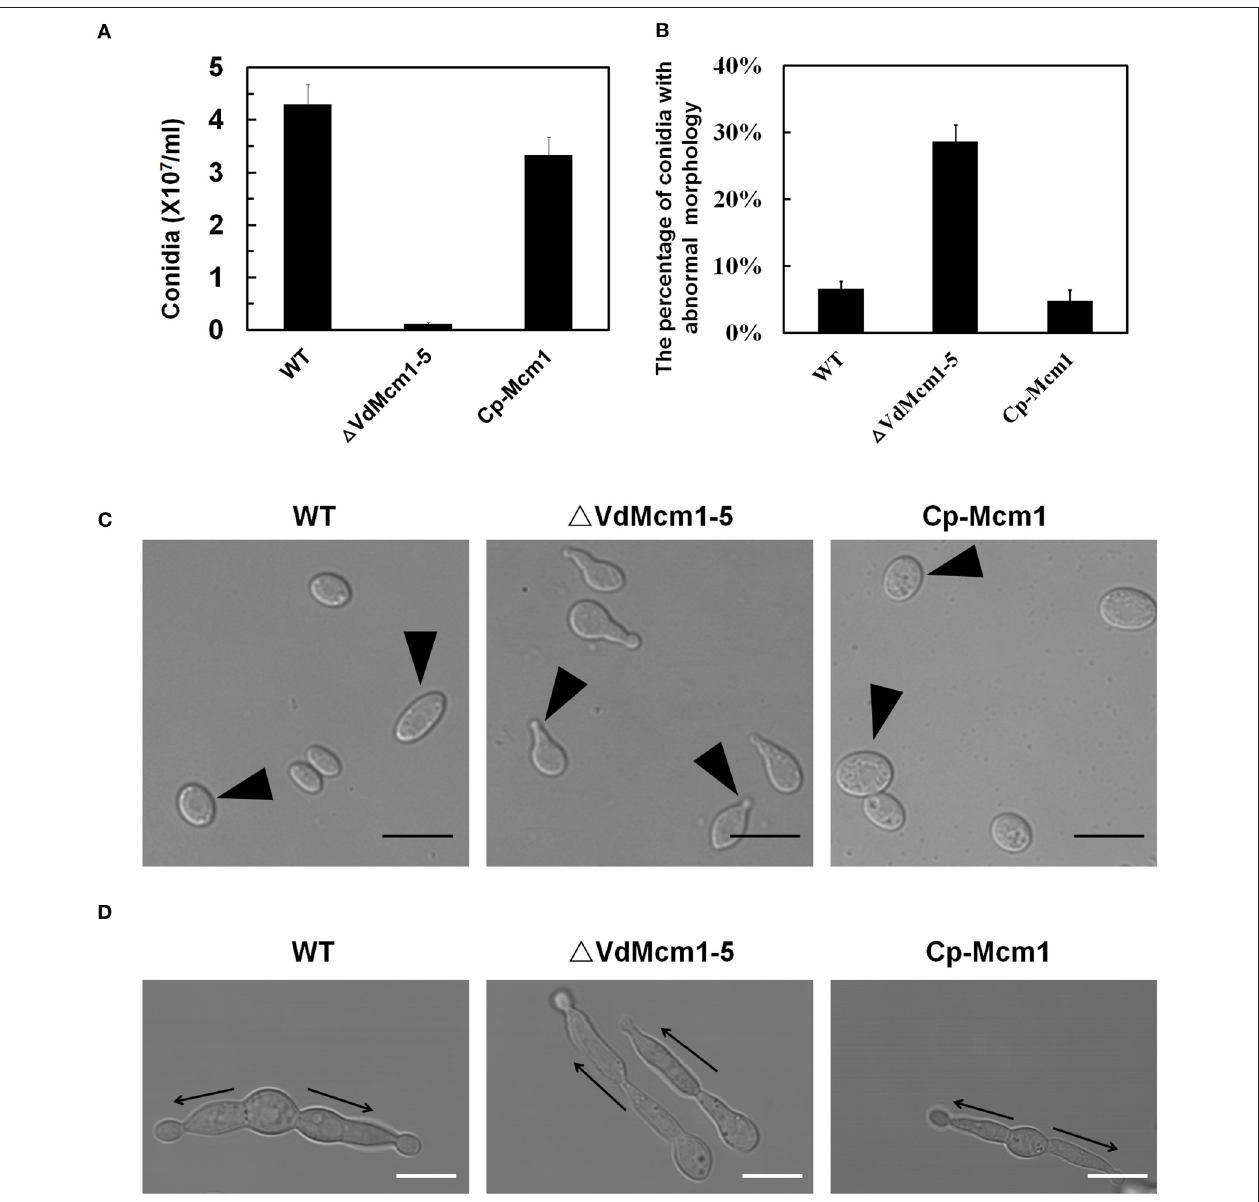
FIGURE 3 | Deletion of VdMcm1 leads to reduced conidial production and abnormal conidial morphology. (A) Conidial production of the wild-type strain, VdMcm1 deletion mutant, and complemented strain after 10 days of growth on PDA plates. (B) The percentage of conidia with abnormal morphology in each strain. (C) Conidial morphology of wild-type strain, VdMcm1 deletion mutant, and complemented strain. Conidia were harvested from cultures in liquid CM for 7 days. The arrowheads indicated normal conidia of wild-type and complemented strains, and abnormal conidia with the protuberance of VdMcm1-5 . The scale bars represent 10 µ m. (D) Germinated conidia of the wild-type strain, VdMcm1 deletion mutant, and complemented strain after 24 h inoculated in YEPD medium. Arrows indicate growth direction. The scale bars represent 5 µ m. The error bars represent standard deviations. The experiments were performed in